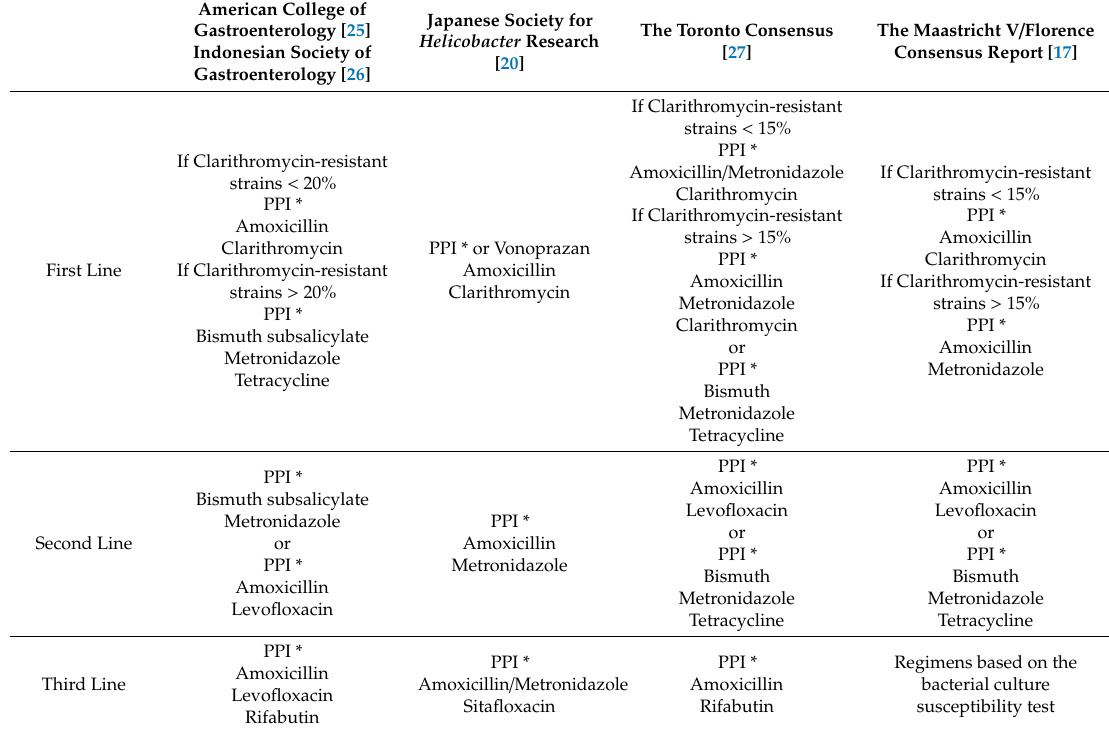
Table 1. Helicobacter pylori eradication therapy regimens based on several